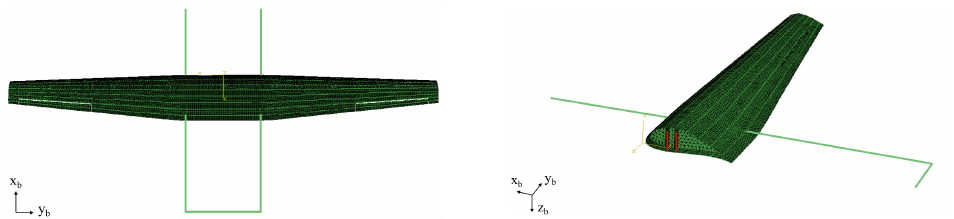
Figure 4. ( left ) Structural model and ( right ) cross-section view. The red lines indicate the clamp- ing